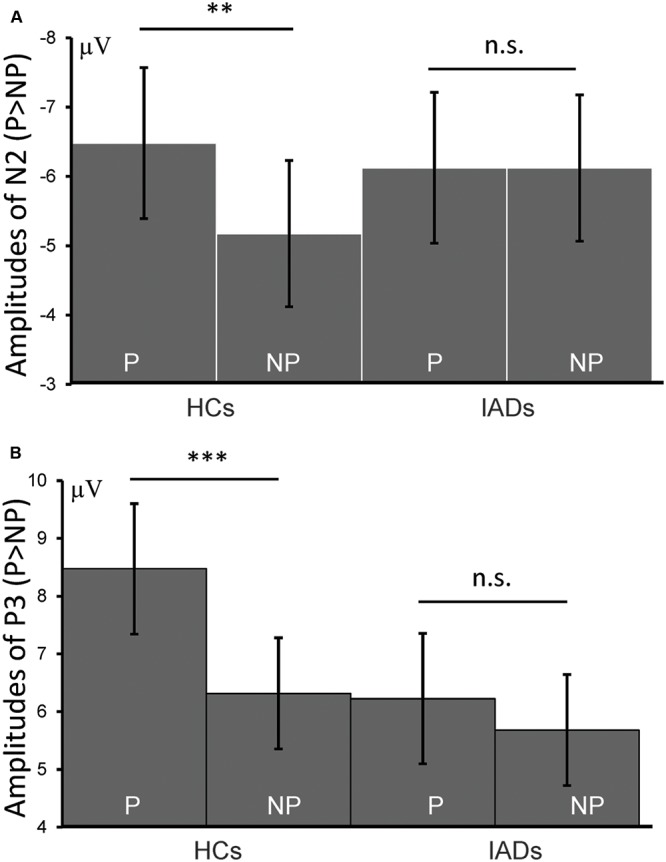
Interactions of picture × group on N2 (A) and P (B) (∗∗∗p < 0.001; ∗∗p < 0.01; n.s., not significant).